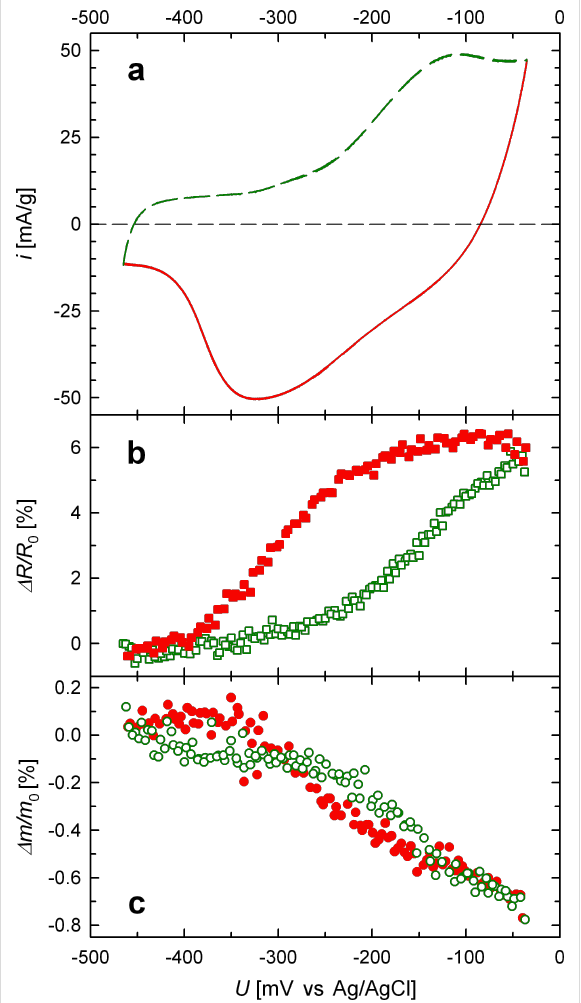
Figure 2: Relative variation of resistance ( Δ R / R 0 , b) and magnetic moment ( Δ m / m 0 , c) of porous nanocrystalline Pt upon electrochemical CV-cycling in 1 M KOH between − 465 mV and − 35 mV. (a) CV measured for sample Pt ER . Measurements of m were performed at 5 kOe. Anodic scan indicated by green dashed line and green open symbols. Cathodic scan indicated by red solid line and red full symbols. To demonstrate the good reproducibility and reversibility two cycles are shown in each